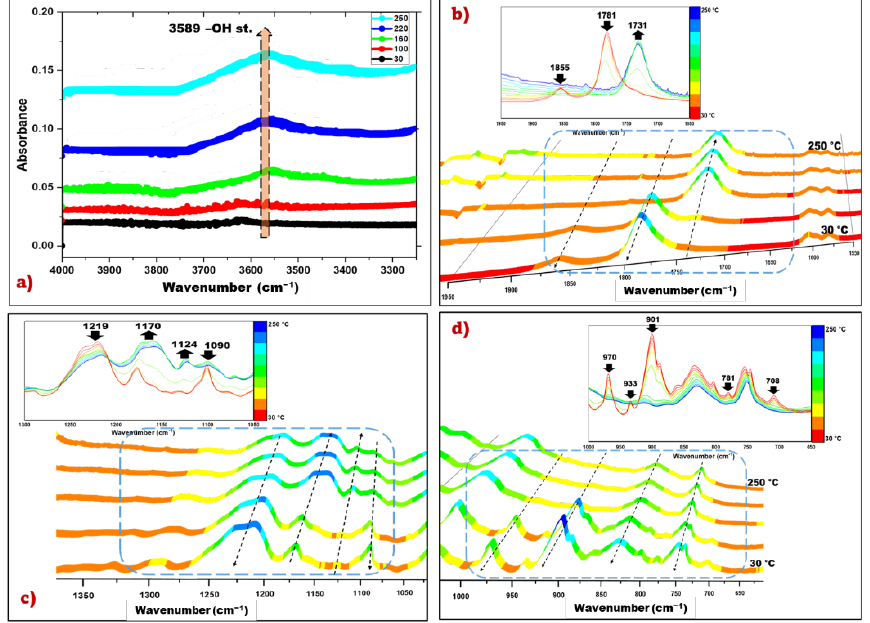
Figure 4. FTIR spectra in function of temperature T-HHPA system in ( a ) 4000 – 3300 cm −1 region; ( b ) 1950 – 1550 cm −1 region; ( c ) 1350 – 1050 cm −1 region and ( d ) 1000 – 650 cm −1 region.